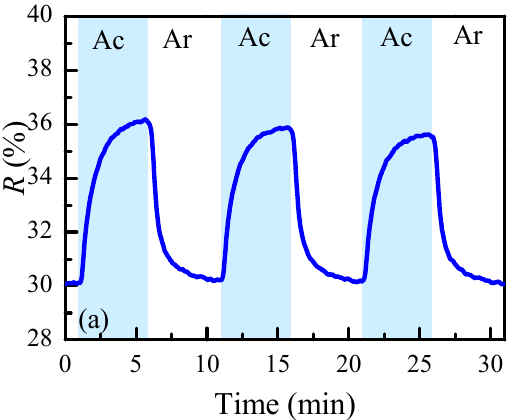
Figure 7. Reflectance measured at a wavelength of 342 nm for copolymer film CP4 within 3 cycles of absorption and desorption of acetone vapors .